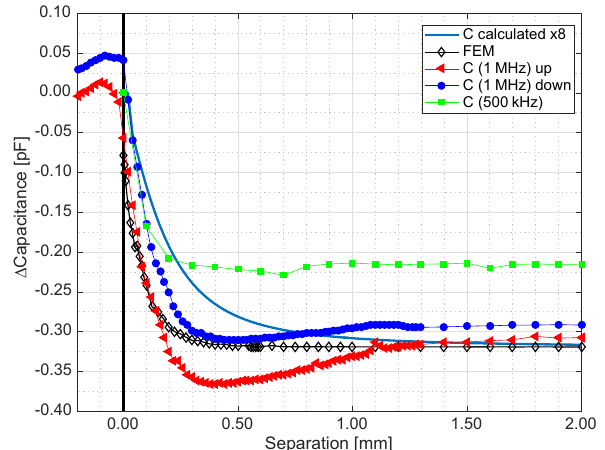
Figure 6. Coplanar capacitive sensing: capacitance versus distance of dielectric load (Delamare et al.,